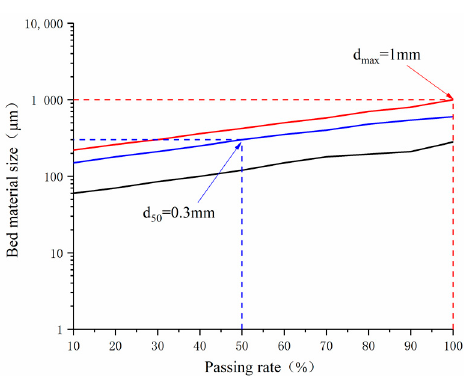
Figure 4. Bed material particle size distribution range.